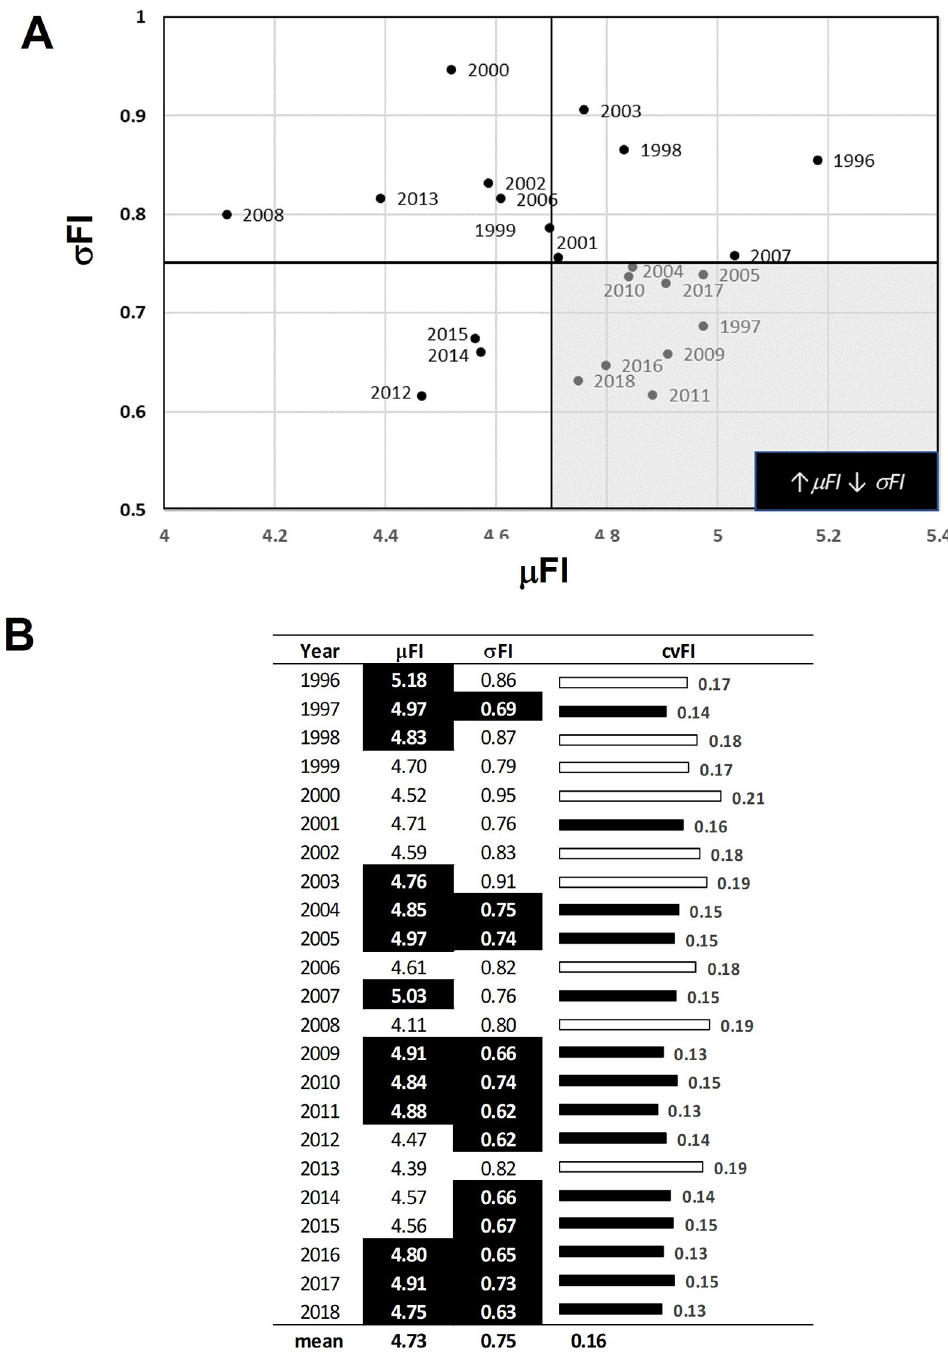
Fig 6. Summary statistics on spatial variation in phytoplankton community (PHYTO) dynamics. (A) The μ FI and σ FI plot helps identify more stable (less variable) time periods which are characterized by high μ FI, low σ FI and cvFI (low right corner). (B) Summary statistics for each year including the cvFI. Highlighted values are those meeting the “stable” regimes criteria for the individual measures ( " μ FI, # σ FI and # cvFI).